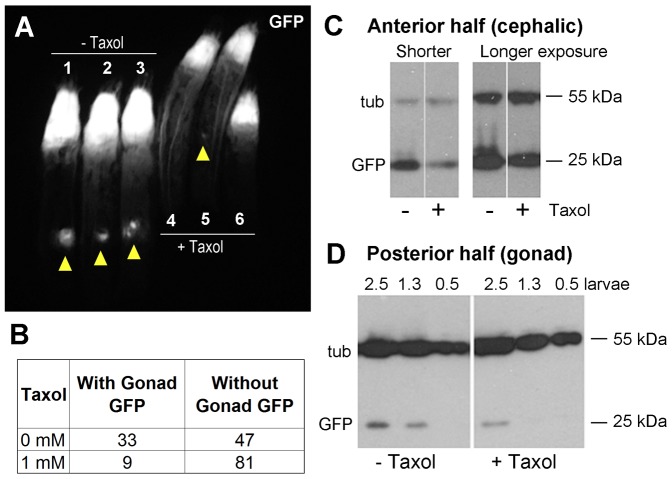
Cephalic and gonad neoplasms are reduced after treatment to Taxol.(A) Larvae were imaged live for GFP on d9 AED. Arrowheads indicate GFP-positive gonads. Quantification of the GFP fluorescence in this image using Image J software showed that Taxol treatment reduced the mean cephalic GFP from 126±12 (mean fluorescence signal arbitrary units, −Taxol) to 81±8 (+Taxol). The difference was significant (P<0.01, 2-tailed Student's t-test). Similarly, Taxol treatment reduced the mean gonadal GFP from 24±7 (−Taxol) to 8±3 (+Taxol). The difference was also significant (P<0.05, 2-tailed Student's t-test). (B) The reduction of gonadal GFP by Taxol was significant (P<10−5, Fisher's exact test, 2-tail). (C,D) Western blots of extracts from anterior (C) or posterior halves (D) of Taxol-treated larvae compared to control vehicle-treated larvae as in panel A. (C) Tubulin signal is the same in −/+ Taxol lane but GFP is reduced in the +Taxol lane. Two different exposures are shown. In panel D, GFP signal is much weaker than the tubulin signal, therefore we loaded ‘larval equivalents’ (see Materials and Methods) and used the tubulin signal to confirm equal loading. For example, 2.5  =  extracts from 2.5 larvae; 1.3  =  extracts from 1.3 larvae. Molecular weight markers are shown along the side. Similar data were obtained in two independent experiments.